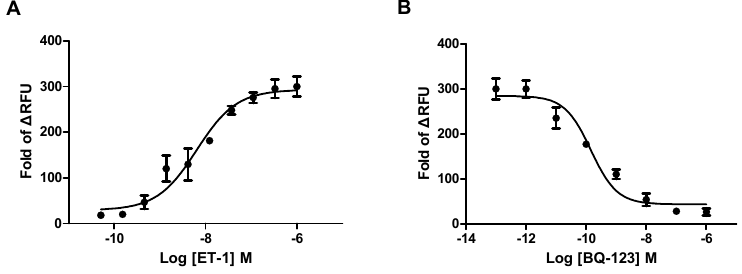
Figure 1. HEK293/endothelin A receptor (ET A R) cell line validation. ( A ) Agonist concentration–response curve of endothelin-1 (ET-1). The EC 50 value of ET-1 was 4.78 nM; ( B ) Antagonist concentration–response curve of BQ-123 (evoked by 20 nM ET-1). The IC 50 value of ET A R antagonist BQ-123 was 0.1 nM. Data were expressed as the fold change of max relative fluorescence units (RFU) and min RFU. Data were from three independent experiments.